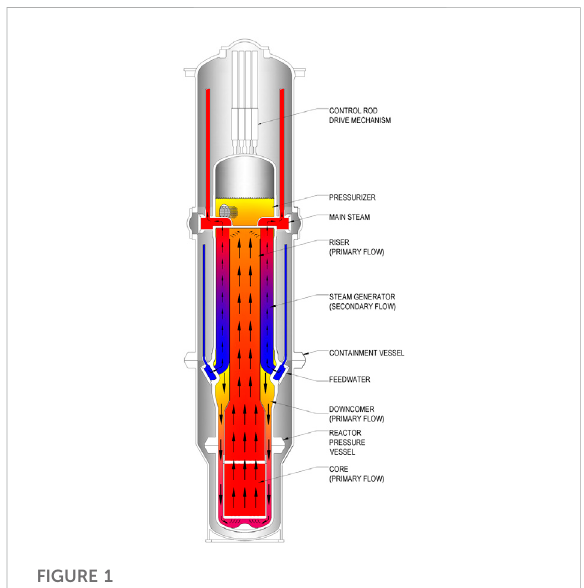
FIGURE 1 Schematic of one NuScale power module (NuScale Power LLC